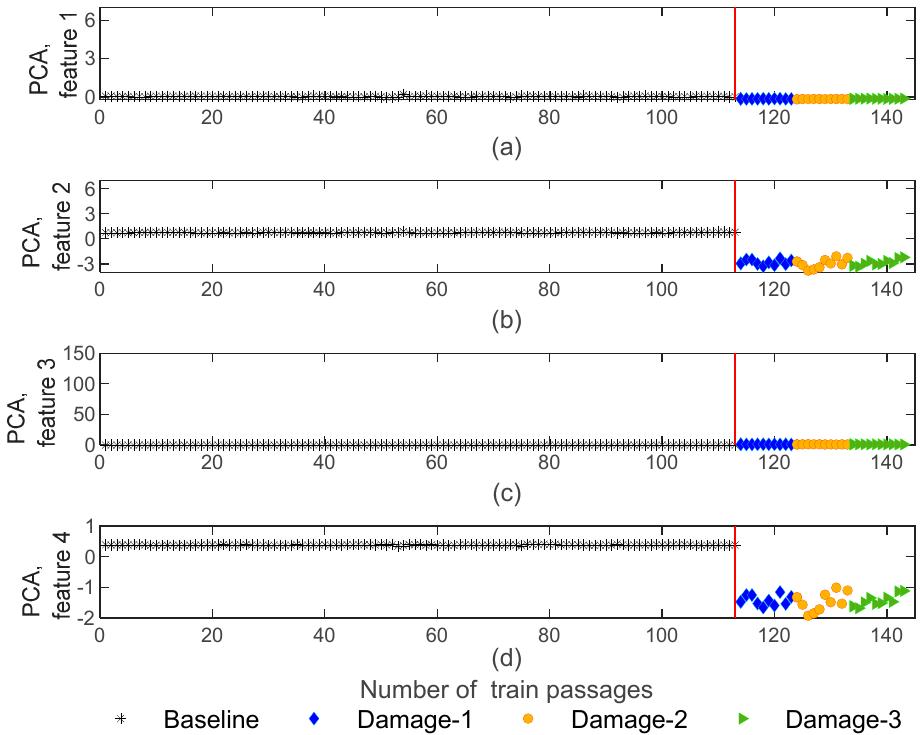
Figure 15. PCA—feature normalization for all 143 baseline and damage scenarios for accelerometer 3: ( a ) PCA for feature 1, ( b ) PCA for feature 2, ( c ) PCA for feature 3, ( d ) PCA for feature 4.